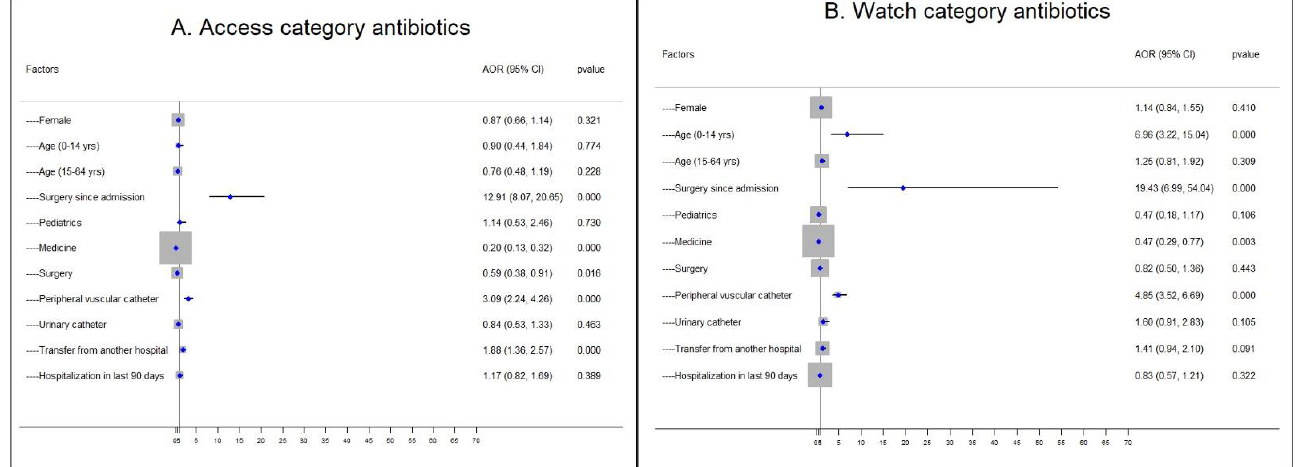
Figure 3. ( A , B ): Multivariate logistic regression model for the association between Access and Watch-group antibiotics and baseline covariates at tertiary and secondary level hospitals in Bangladesh from February to April 2021.